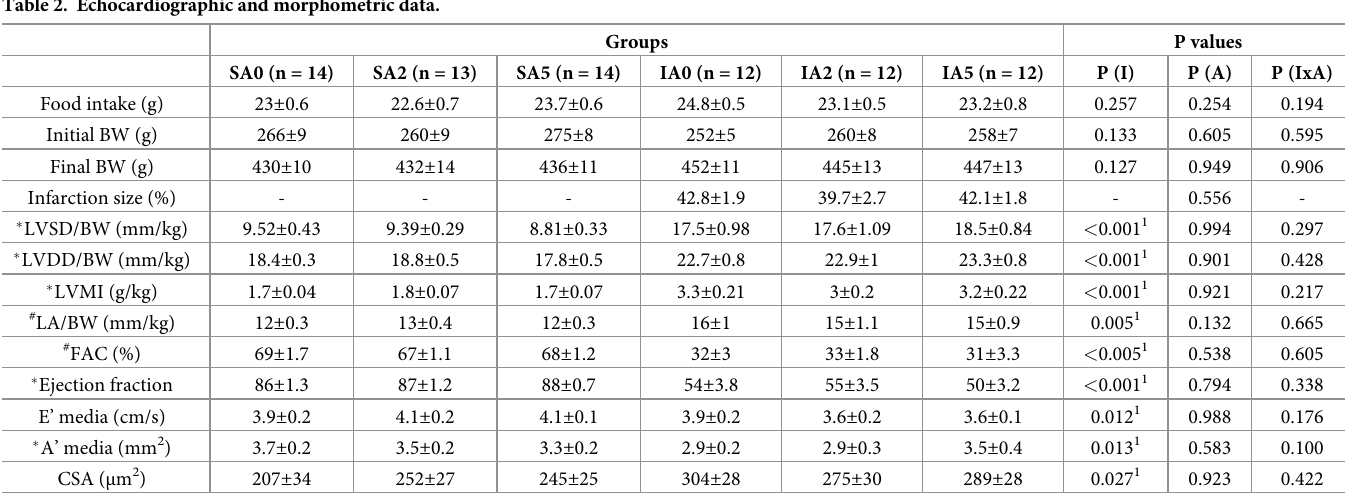
Table 2. Echocardiographic and morphometric data.